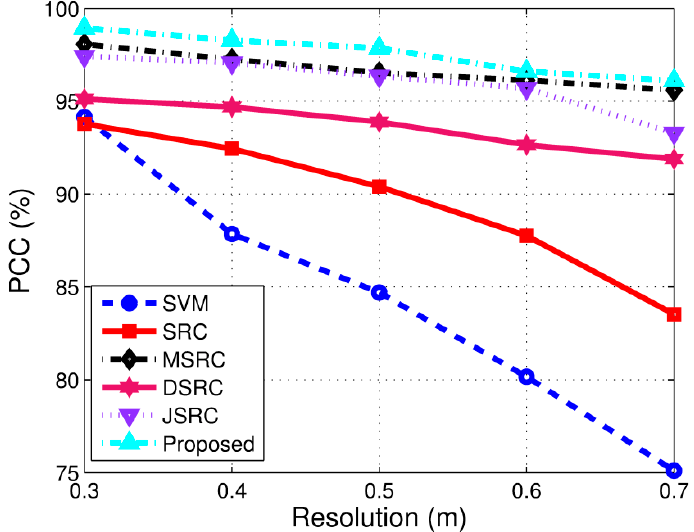
Figure 16. PCCs of different methods under different resolutions.